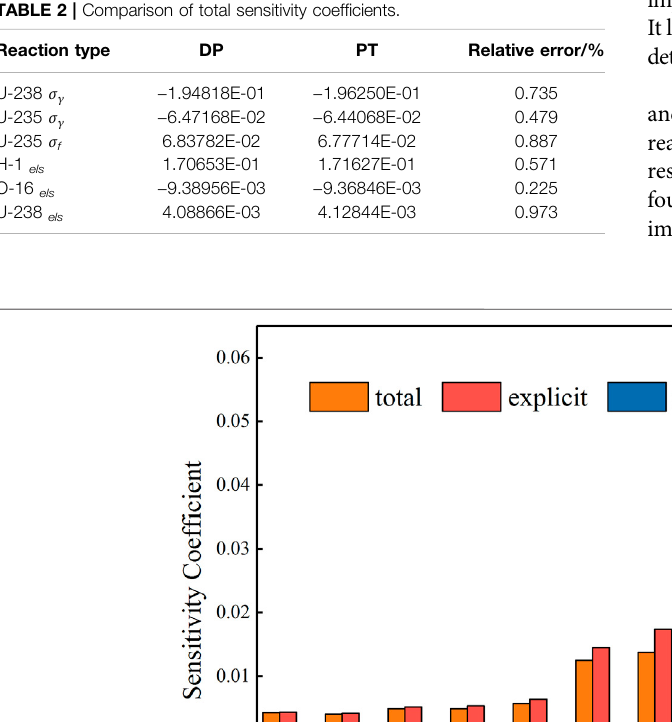
Frontiers in Energy Research |